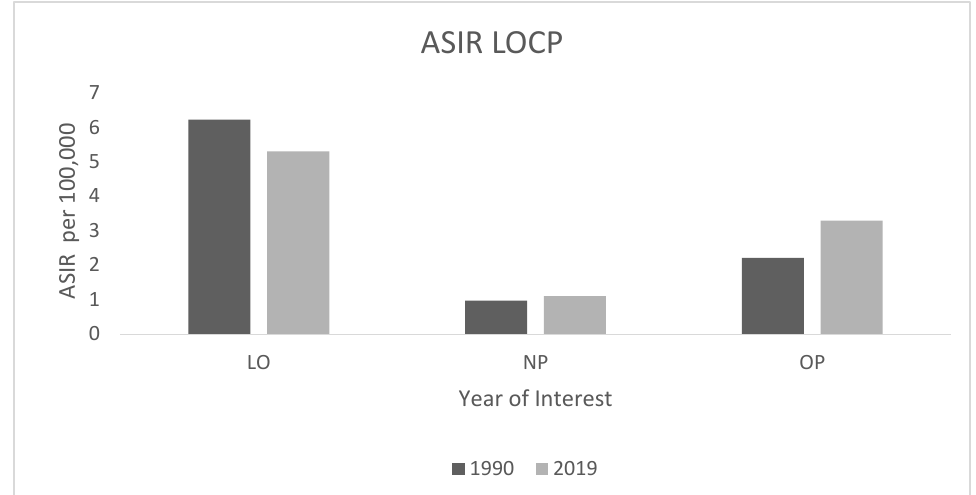
Figure 2. ASIR of LOCP between in 1990 and 2019. LO: lip and oral cavity cancer; NP: nasopharynx cancer; OP: other pharynx cancer.